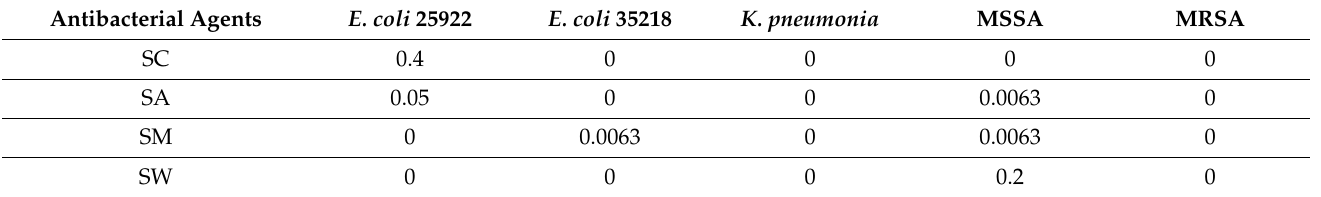
Table 2. Minimum bactericidal concentration (MBC) of chemically synthesized silver nanoparticles, as well as their conjugates. Antibacterial